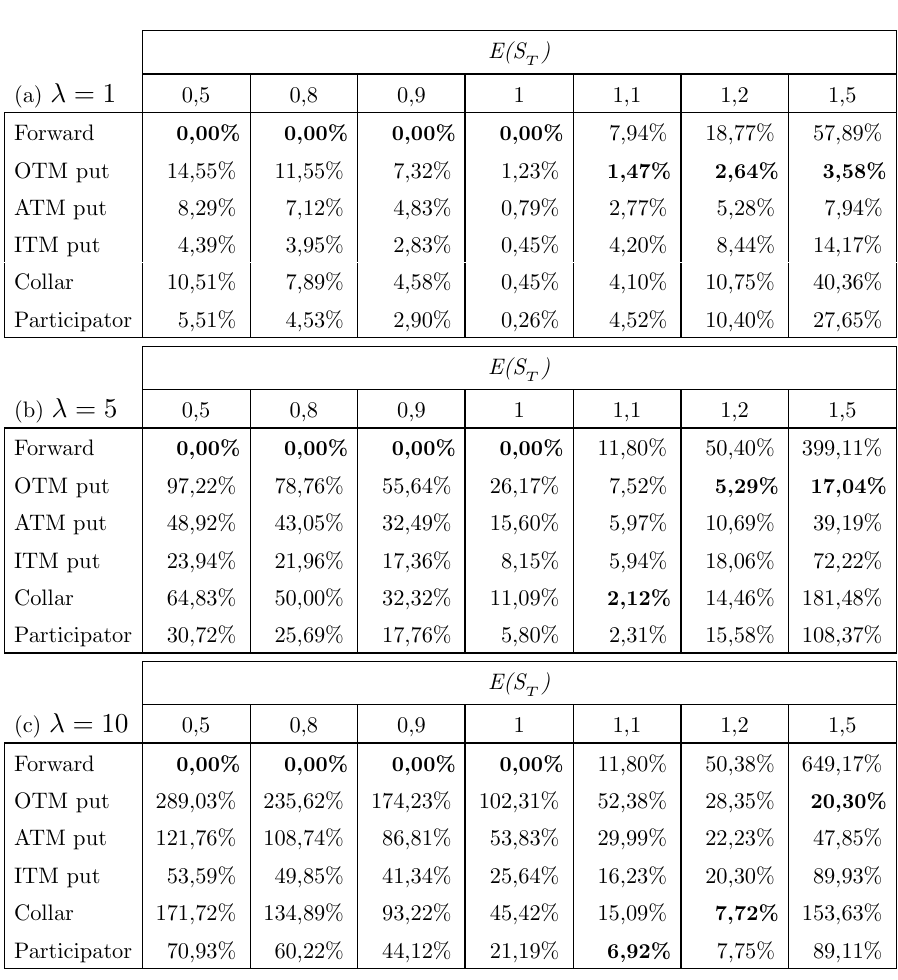
The effectiveness of hedging ζ for different expected prices and risk aversion